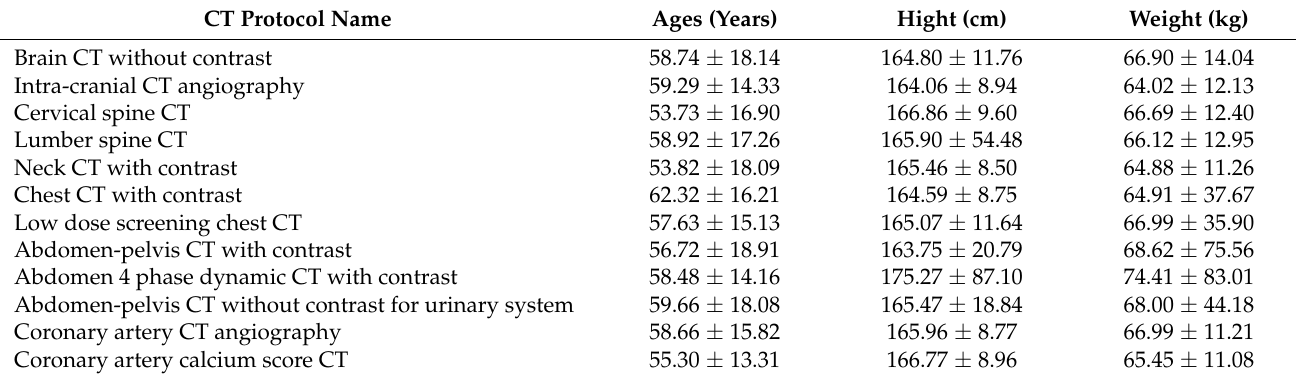
Table 2. Patients’ average age, average weight, and average high of adult CT